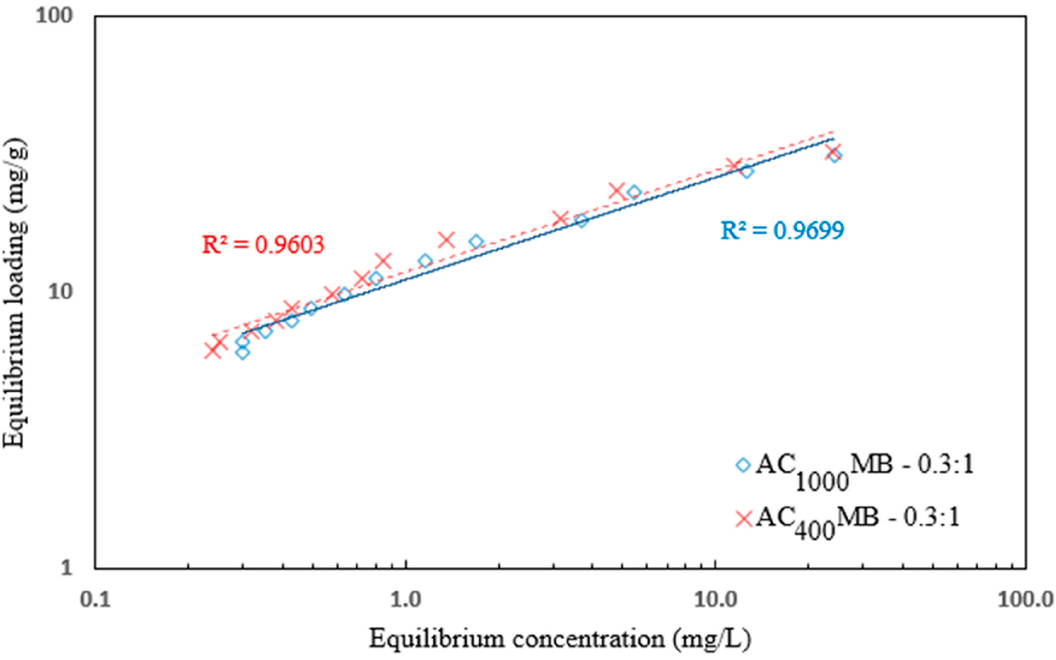
Figure 16. Freundlich isotherm for DB78 dye removal using AC 400°C MB-0.3:1 and AC 1000°C MB-0.3:1.